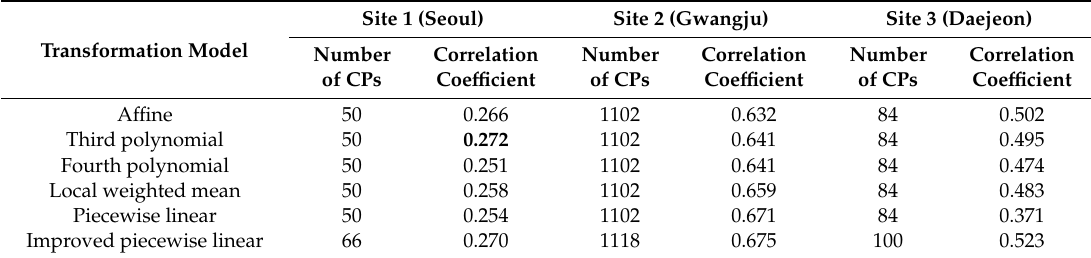
Table 3. Comparative accuracy of warping transformation models (real